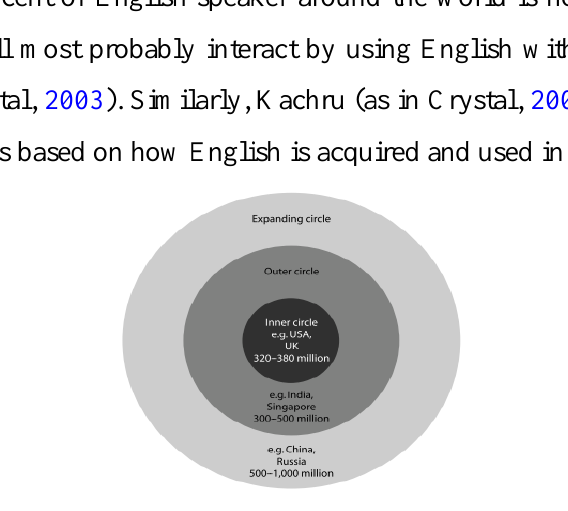
Figure 1.Kachru’s three circles (Crystal, 2003, p.